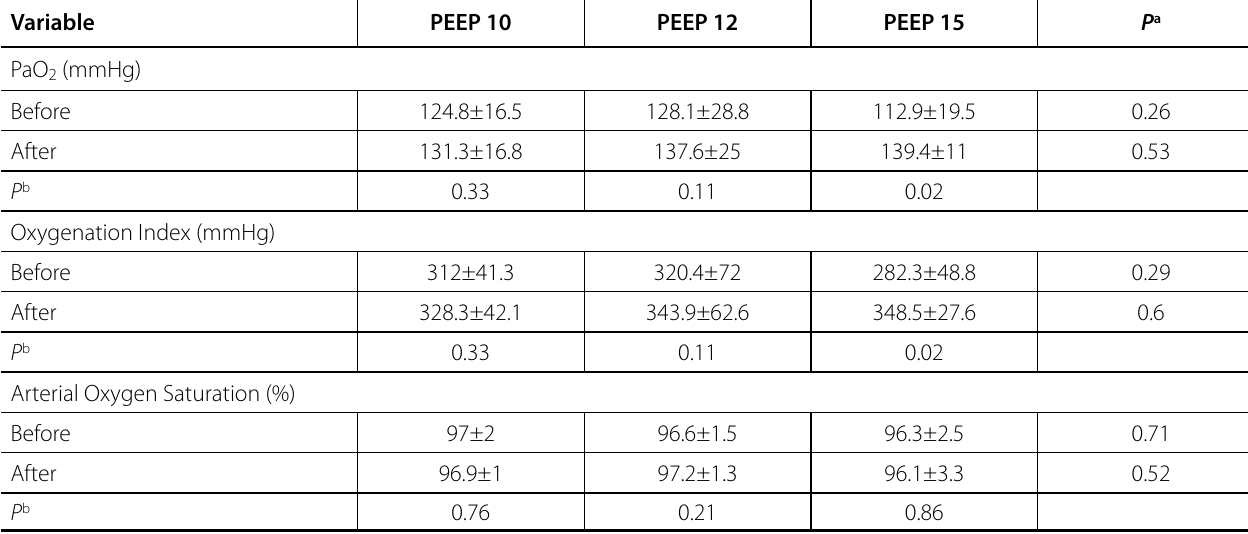
Table 3. Analysis of oxygenation in patients undergoing cardiac surgery.